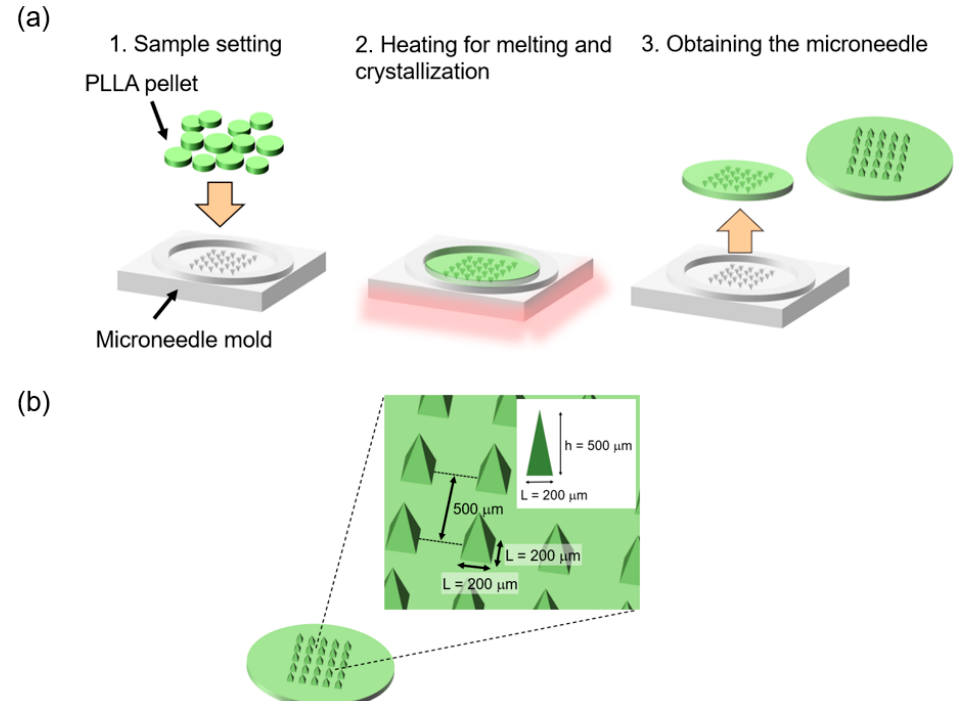
Figure 2. ( a ) Schematic illustration of the procedures of the micromolding process for fabricating the PLLA microneedles. ( b ) The dimensions of the fabricated PLLA microneedles.